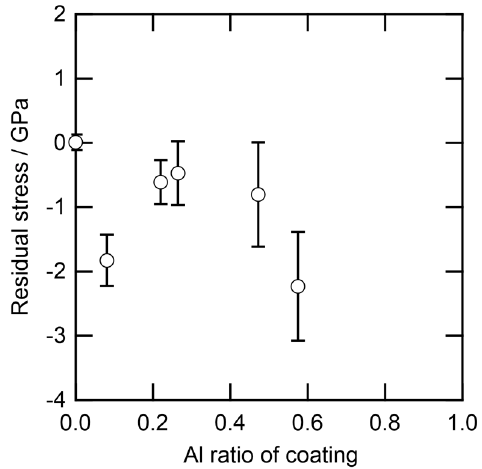
Figure 6. Change in residual stress of TiAlN coatings with different Al compositions.